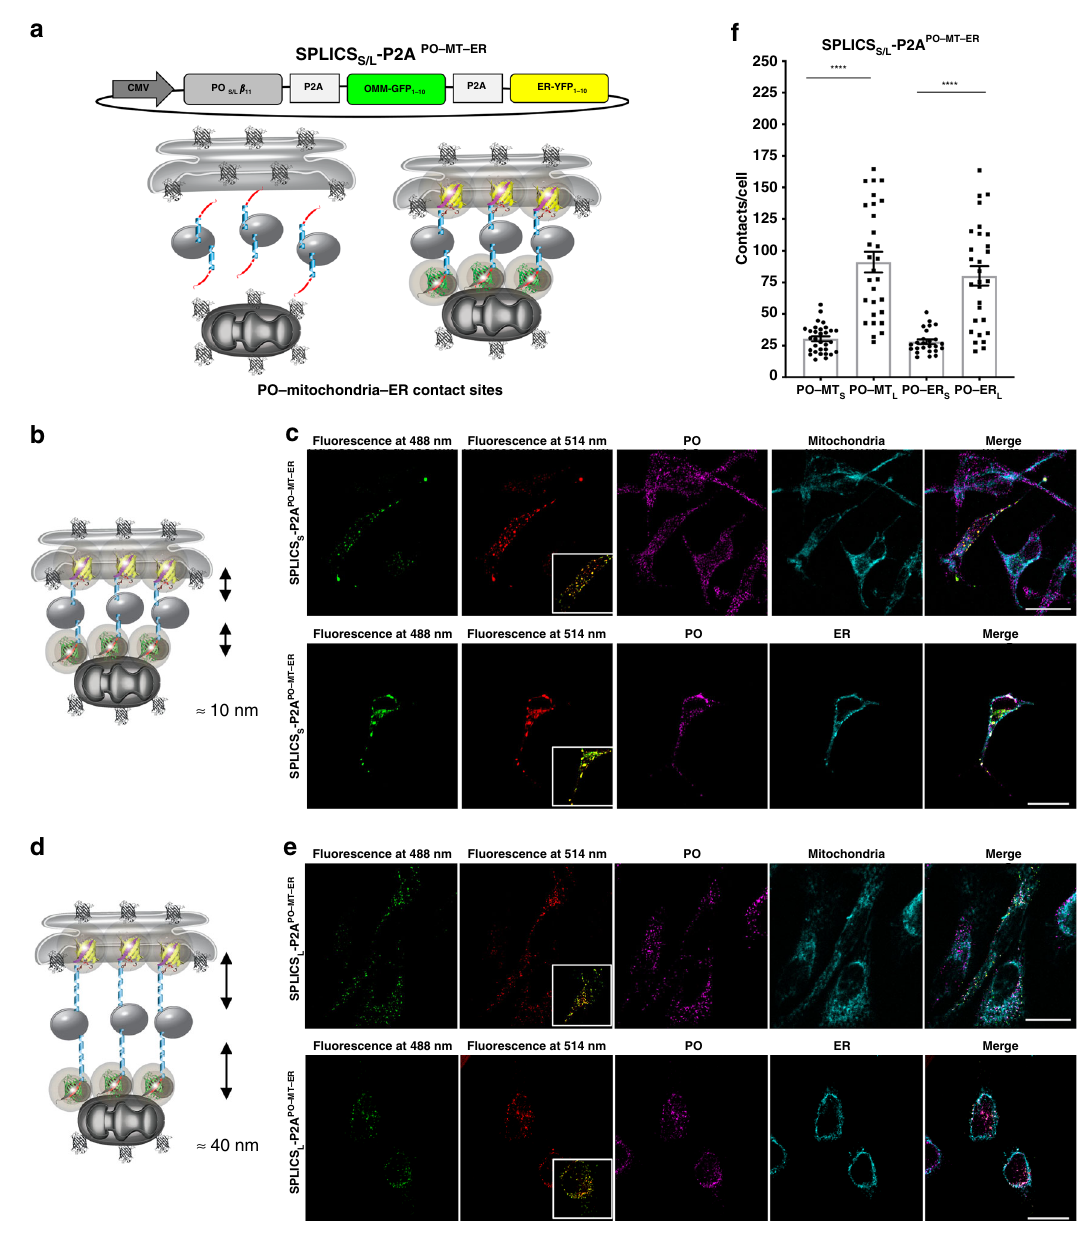
Fig. 5 Functional characterization of SPLICS S/L sensors to detect the PO – mitochondria and the PO – ER interfaces simultaneously. a Schematic representation of the constructs SPLICS S/L P2A PO – MT – ER able to detect short (8 – 10 nm) and long (40 – 50 nm) range contact sites between the ER – mitochondria and the ER – PM simultaneously in different spectral variants. The cartoon shows the approach used to design the SPLICS reporters and indicates that the complementation of either short- and long-range PO- β 11 fragments with OMM-GFP 1 – 10 and ER-YFP 1 – 10 will reveal a fl orescence signal at the level of the contact sites. b , d Cartoon showing the short- and long-range contact sites measured by the indicated reporters. Confocal single plane images of HeLa cells transfected with SPLICS S P2A PO – MT – ER c and SPLICS L P2A PO – MT – ER e showing the appearance of fl uorescent “ dots ” upon excitation at 488 and 514 nm wavelengths con fi rming the complementation with GFP 1 – 10 (in green) and YFP 1 – 10 (in pseudocolour, red) at the PO – MT and the PO – ER contact sites, respectively. The co-localization of the SPLICS S/L P2A PO – MT – ER reporters with endogenous markers of PO (PMP70)/mitochondria (TOM20) (upper panels) and PO (PMP70)/ER (KDEL) (lower panels) is shown. Scale bar 25 µ m. f Quanti fi cation of the PO – mitochondria and the PO – ER (short and long) contacts in HeLa cells. The SPLICS dots were quanti fi ed from the 3D rendering of a complete Z-stack, mean ± SEM. The data were obtained from three independent transfections. (**** P ≤ 0.0001 unpaired two-tailed t -test). Source data are provided as a source data fi